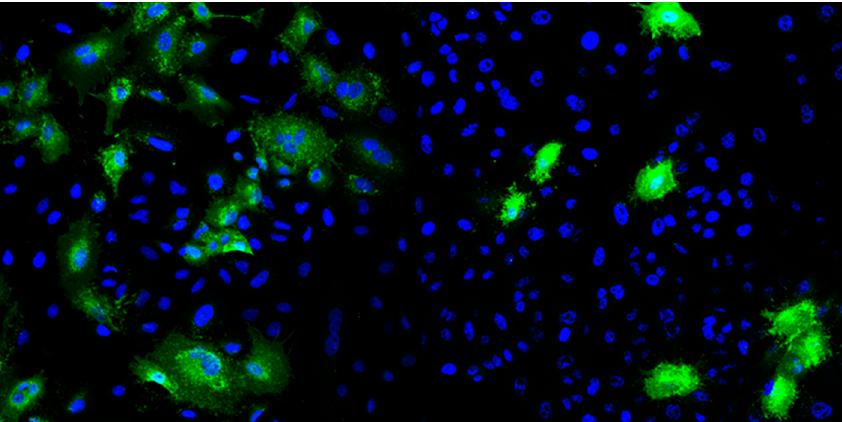
Figure 2. Example of HeLa cells with stained nuclei (blue) and RSV F protein (green) after 24 h of infection.